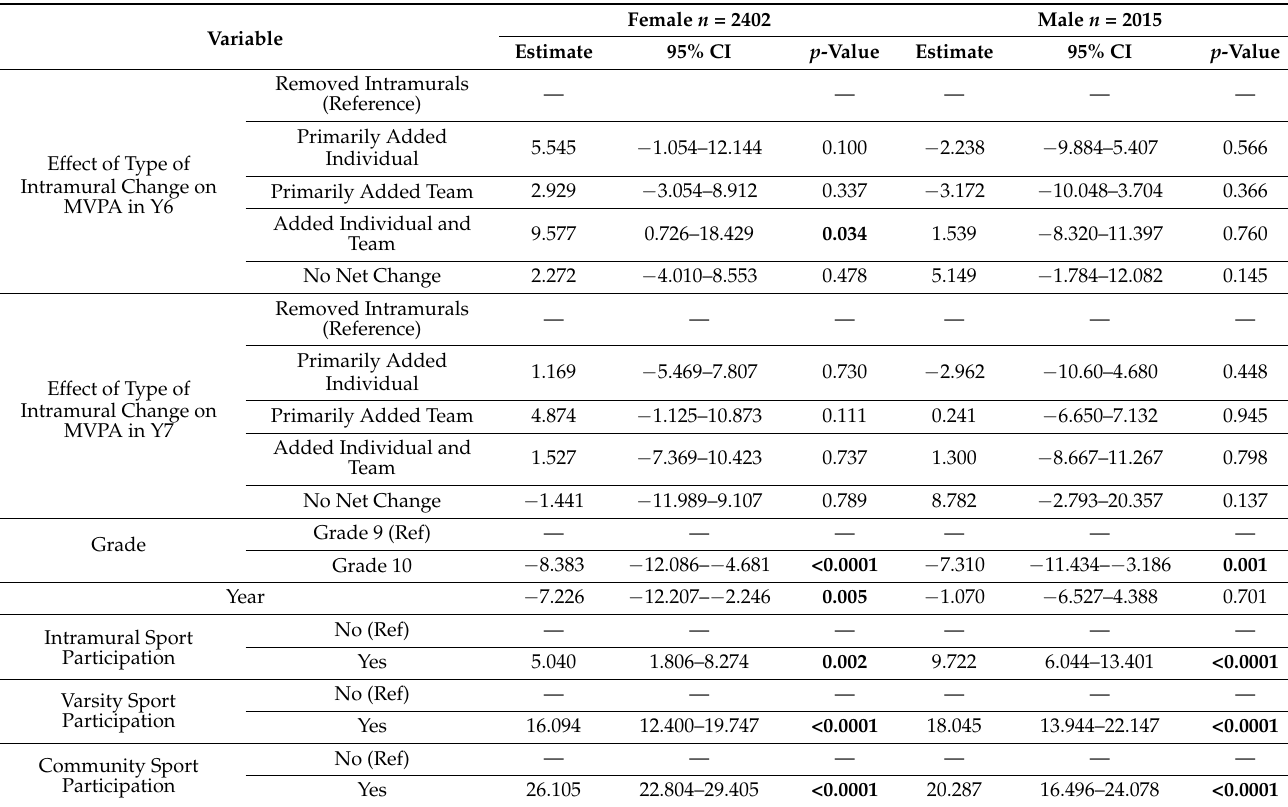
Table 4. Linear Mixed Models examining the association between changes in intramural programming in Y6 on MVPA in Y6 and Y7 of the COMPASS Study stratified by